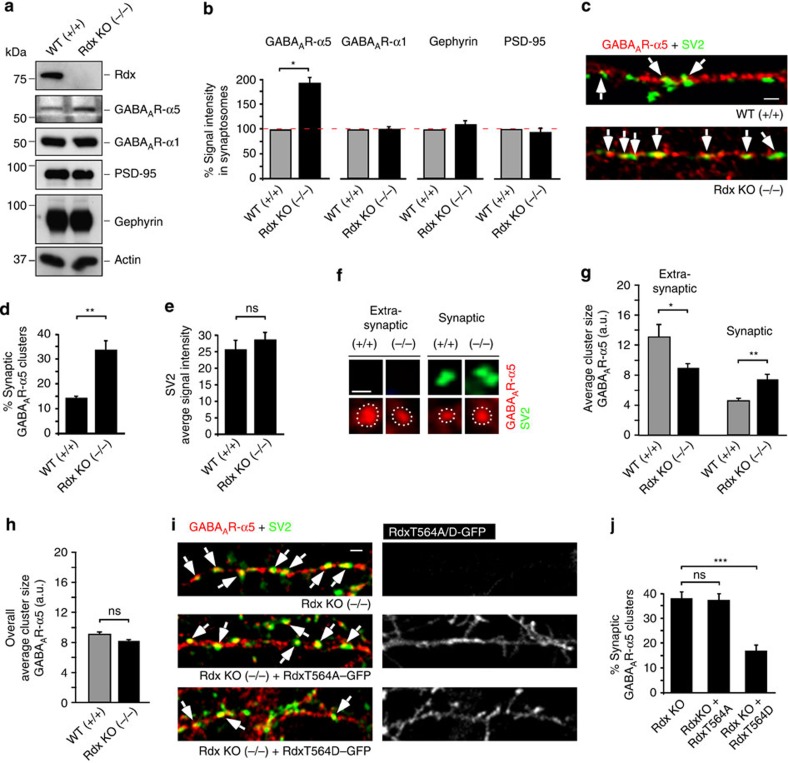
Rdx depletion in mice increases GABAAR-α5 synaptic concentration and cluster size that is reversible through RdxT564D expression.(a) GABAAR-α5 is specifically and significantly enriched in synaptosomes from Rdx-depleted (−/−) compared with WT control (+/+) mouse forebrain lysates. (b) Quantification of three independent experiments. Note: GABAAR-α5 levels are increased in synaptosomes derived from Rdx (−/−) (173.88±14.10%) mice, whereas GABAAR-α1 (99.39±2.63%), gephyrin (112.60±6.86%) and PSD-95 (94.74±8.51%) levels remain unaltered compared with WT (+/+) controls (set to 100%). (c) Synaptic localization of GABAAR-α5 in dendrites (arrows) of hippocampal neurons derived from WT (+/+) and Rdx (−/−) mice. (d,e) Rdx depletion causes significant enrichment of GABAAR-α5 in apposition to SV2-positive pre-synaptic terminals ((+/+): 14.29±0.38%, (−/−): 33.60±3.44%). However, it does not alter SV2 average signal intensities ((+/+): 25.53±2.79, (−/−): 28.51±2.07) (n=3 with 5–14 cells per experiment). (f) Representative GABAAR-α5 cluster sizes at synaptic and extrasynaptic sites in hippocampal neurons from WT (+/+) and Rdx (−/−) mice. (g,h) Analysis of GABAAR-α5 cluster sizes revealed enlarged synaptic clusters ((+/+): 4.57±0.36 a.u., (−/−): 7.40±0.23 a.u.) accompanied by decreased extrasynaptic (SV2 negative) clusters on Rdx depletion ((+/+): 13.07±0.32 a.u., (−/−): 8.98±0.25 a.u.). Notably, the quantification of pooled synaptic and extrasynaptic cluster size (h) reveals no significant difference between both genotypes ((+/+): 9.05±0.22 a.u., (−/−): 8.16±0.16 a.u.). (i,j) Synaptic localization of GABAAR-α5 in dendrites (arrows) of hippocampal neurons derived from Rdx (−/−) after expression of RdxT564A–GFP (37.43±2.60%) and RdxT564D–GFP (16.96±2.79%), as compared with non-GFP-expressing cells (38.08±2.69%) of the same culture (see grey panels in i for GFP signals). Error bars, mean±s.e.m. Scale bars, (c,i) 3 μm, (f) 1 μm. The Student's t-test (b,d,e) or ANOVA (g,h,j) was used for statistical analysis (**P<0.01; *P<0.05). NS, not significant.